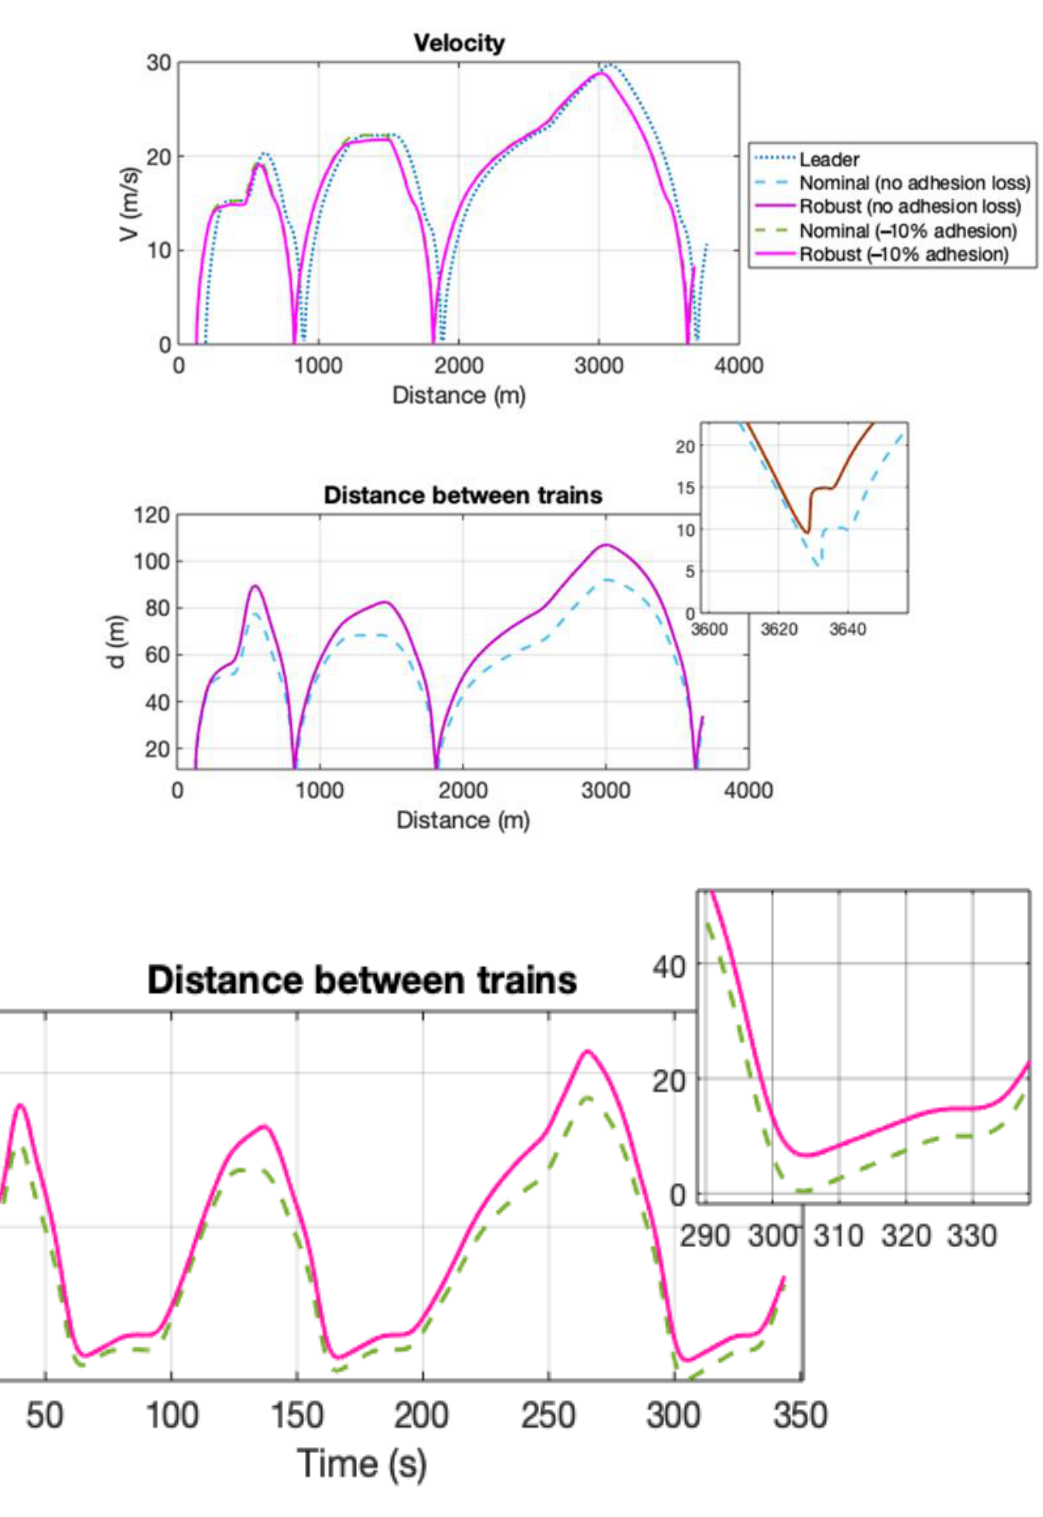
Figure 4. Results of simulation 1: 10% adhesion loss. Variables versus time.